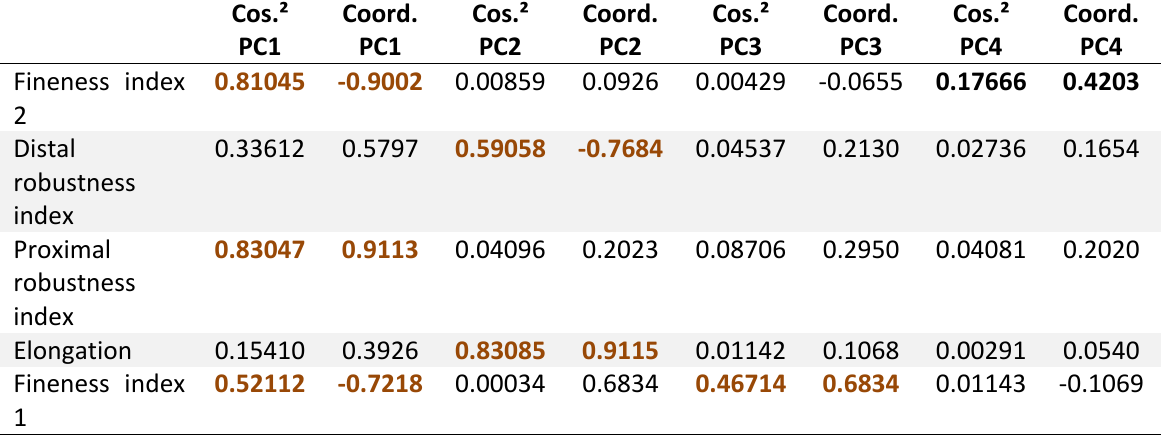
Table 5. Coordinates of the first four PCs and their cos 2 from the PCA1 presented in Figure 11. Variables with highest contribution and quality of representation on the PCs are shown in